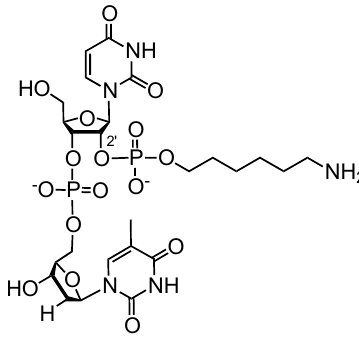
Figure 3. Chemical structure of dinucleotide 1a .